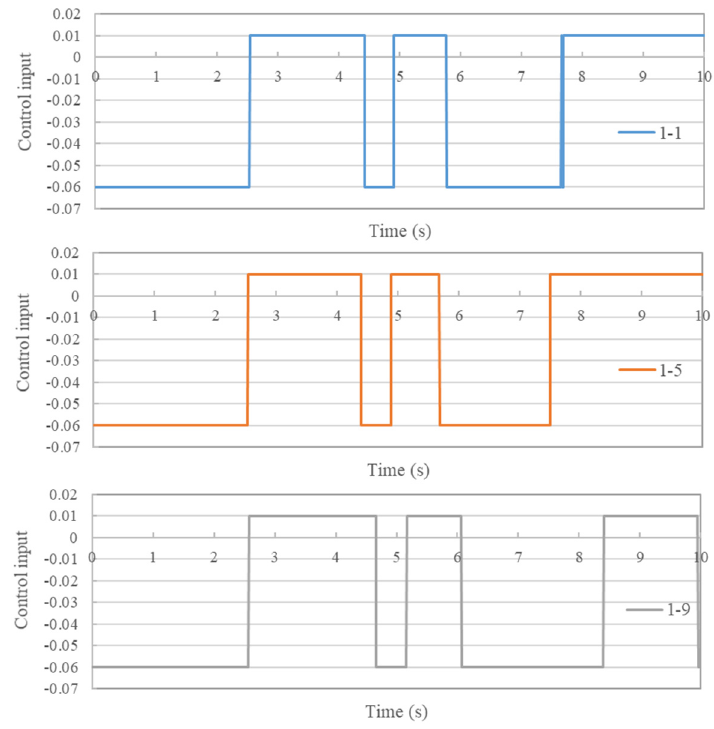
Figure 12. Time history of control input.